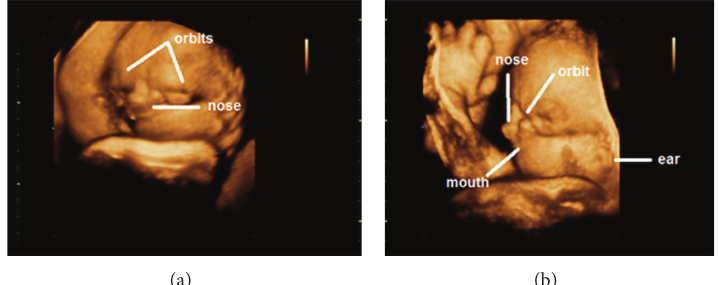
Figure 1: (a) and (b) Three-dimensional rendering image of the fetal face, showing transverse facial fissure, microphthalmia, and low-set ears.